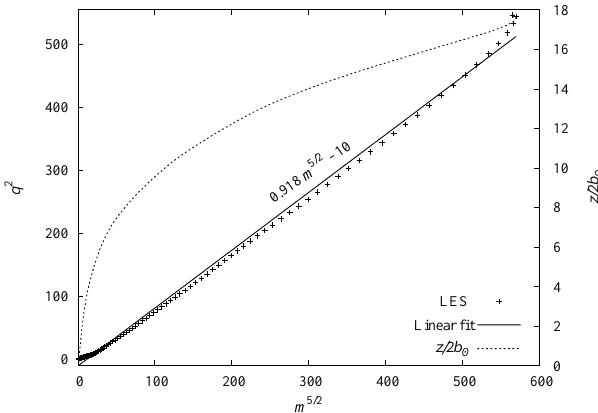
Figure 12. Linear regression between m 5 / 2 and q 2 for the plume simulation with azimuthal